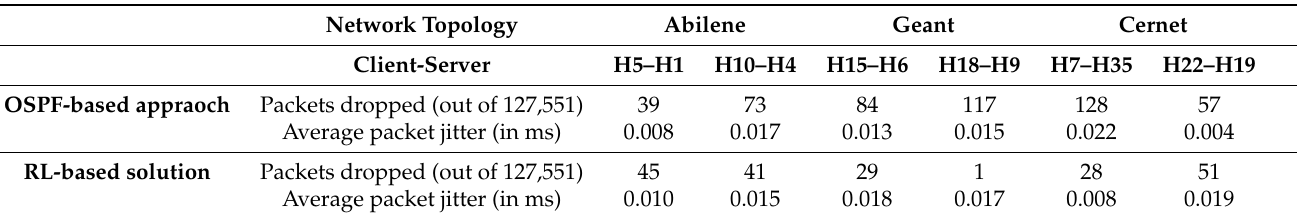
Table 3. The number of packets dropped and average jitter during video transmission for the low background traffic load under three topologies (includes random client-server from each net- work topology).